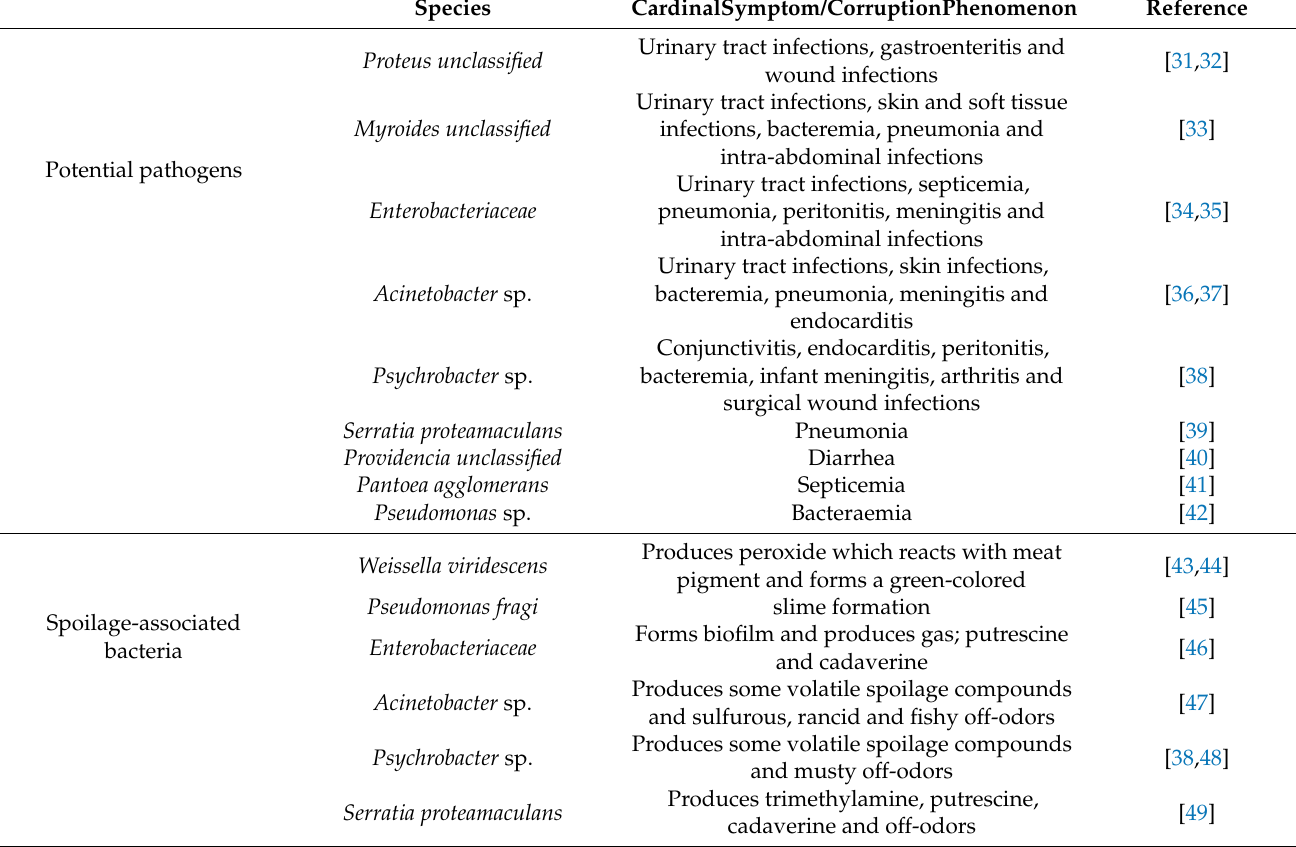
Table 2. Cardinal symptoms by potential pathogens and spoilage-associated bacteria. Species